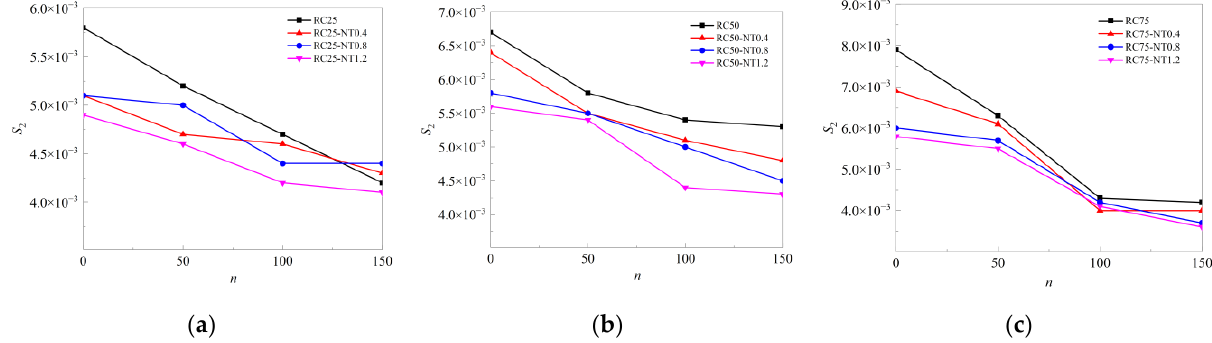
Figure 7. The variation curve of initial water absorption S 2 with freezing – thawing cycle n. ( a ) R25 group; ( b ) R50 group; ( c ) R75 group.